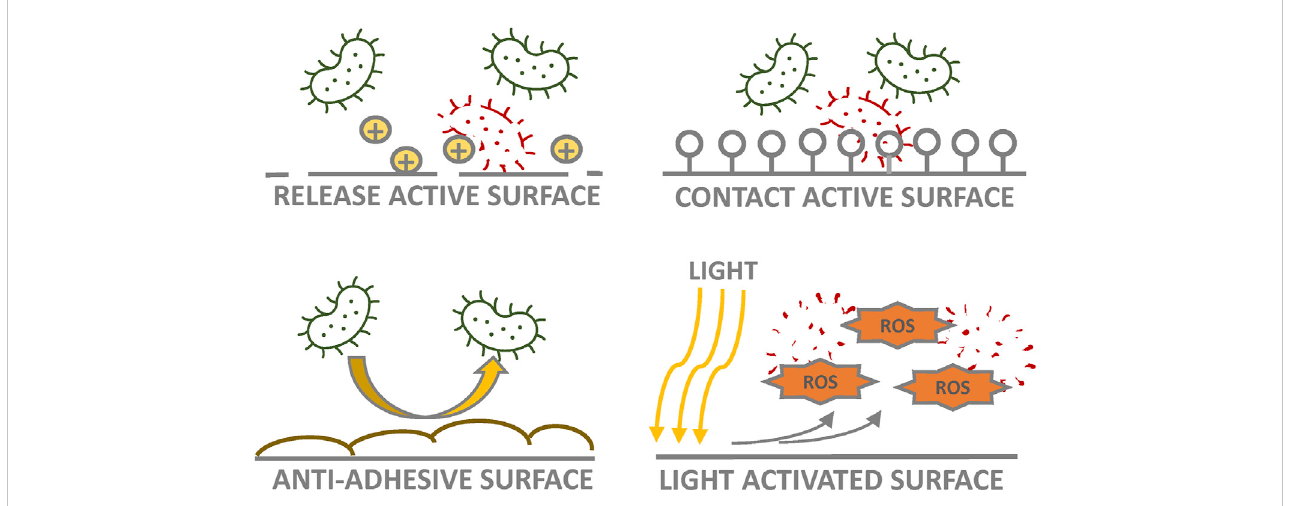
FIGURE 2 Four basic antimicrobial surface types. The biocide-release surface is preloaded with biocides to be released from the surface (e.g., metal ions) for antimicrobial action. On the contact-active surface, biocide is permanently immobilized on the surface (e.g., covalently bound quaternary ammonium compounds) and presents antimicrobial action when microbes come in close contact with the surface. The anti-adhesive surface (e.g., superhydrophilic polyethylene glycol) prevents microbial adhesion and accumulation on the surface, thus reducing the number of attached microorganisms. The light- activated antimicrobial material (e.g., titanium dioxide) destroys microorganisms via the production of reactive oxygen species under speci fi c wavelengths of